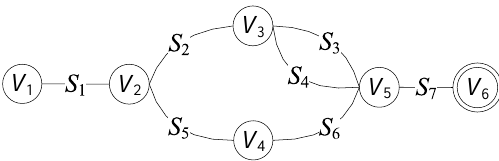
Figure 3. The UIGraph for the query Q